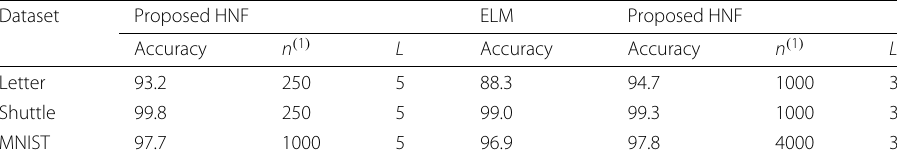
Table 2 Test classification accuracy of the proposed HNF for different datasets using DCT Dataset